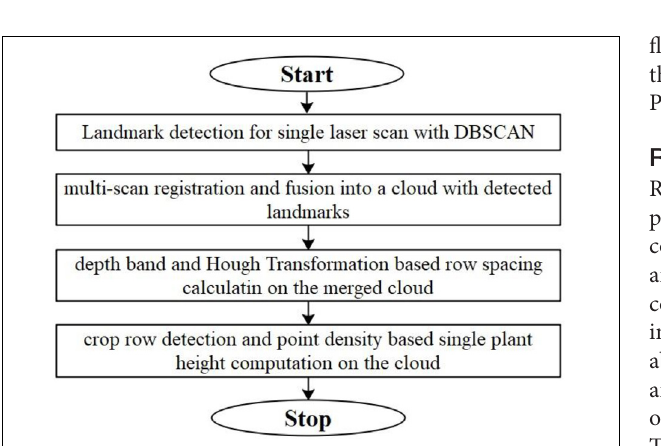
layouts of the two different parcels. The green area stands for the maize field. The gray area stands for the cement floor. The orange rectangle stands for the landmark. The red circle stands for the data collection spot. The arrow points out the moving direction of AgRover-01. The coordinate system for each parcel scenario is marked in Figure 4 . We select the origin of the LiDAR’s coordinate system at the last observation spot as the origin of the global coordinate system for each scenario. We define the direction facing to the maize field as the positive direction of X coordinate, the left side direction as the positive direction of Y coordinate, and the upward direction as the positive direction of Z